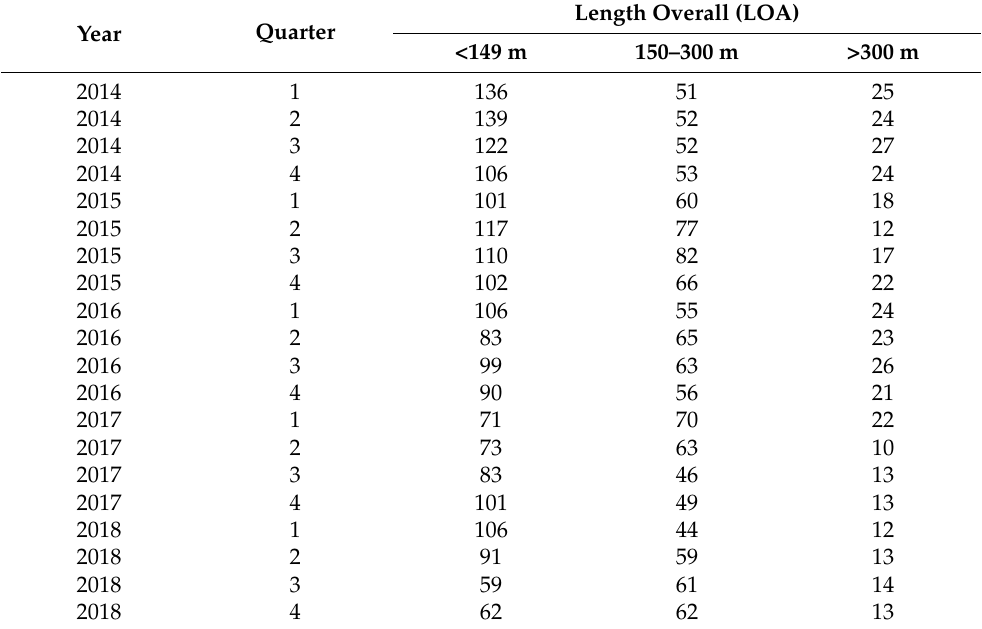
Table 4. Number of ships arriving at the port of Gothenburg by